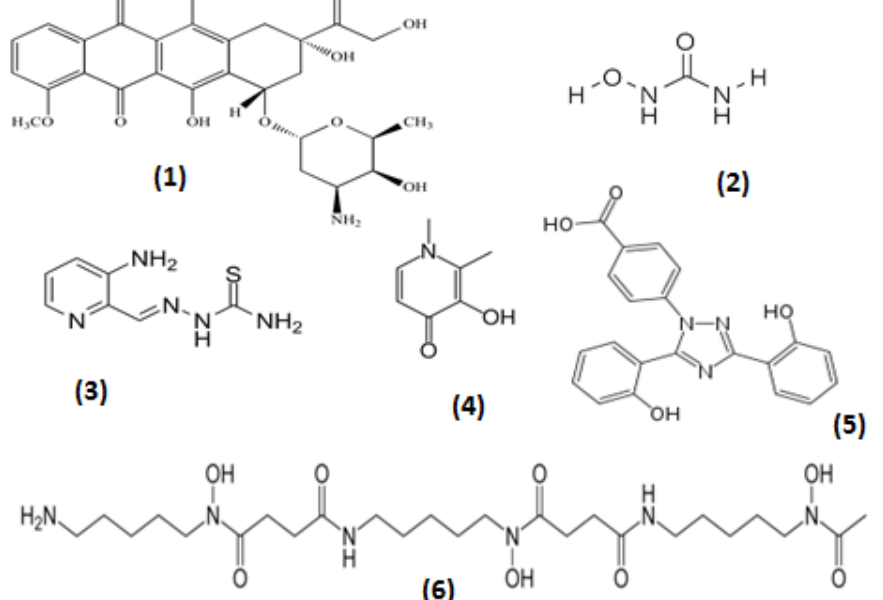
Figure 1. The chemical structure of anticancer drugs and chelating drugs with high affinity for iron. The anticancer drugs doxorubicin ( 1 ) and hydroxyurea ( 2 ) are widely used in cancer patients, triapine ( 3 ) is undergoing clinical trials in cancer and the iron-chelating drugs deferiprone (L1) ( 4 ), deferasirox ( 5 ) and deferoxamine ( 6 ) are widely used in iron-overloaded patients for the removal of excess iron.